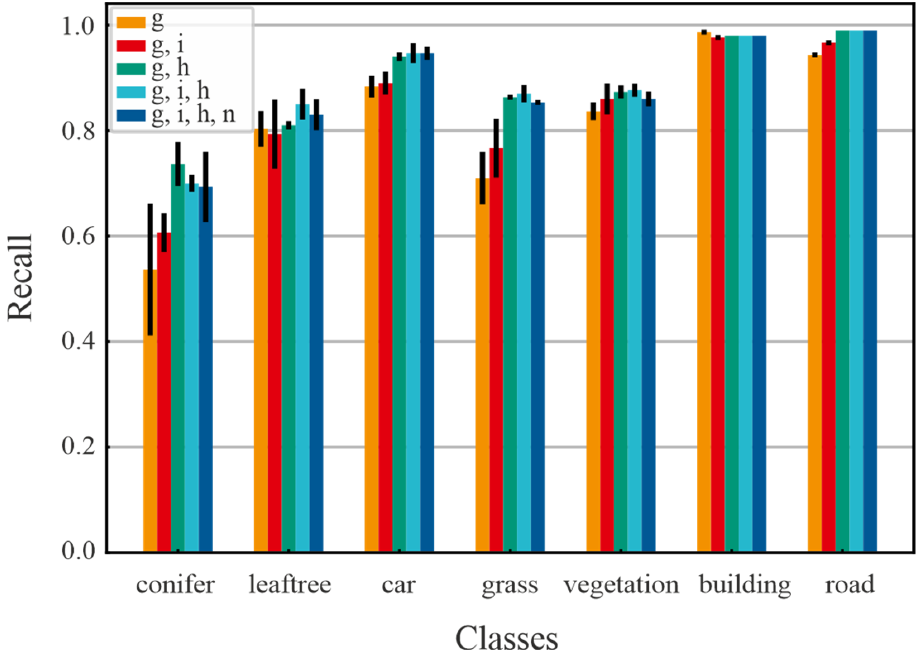
Figure A2. Visualization of the training results. Here the recall of each class is shown for the trainings using just geometry (g), geometry and intensity (g, i), geometry and DAV (g, h), geometry, intensity and DAV (g, i, h) and geometry, intensity, DAV and number of points (g, i, h, n). The black bars indicate the standard deviation calculated from the three separate trainings for each setting.